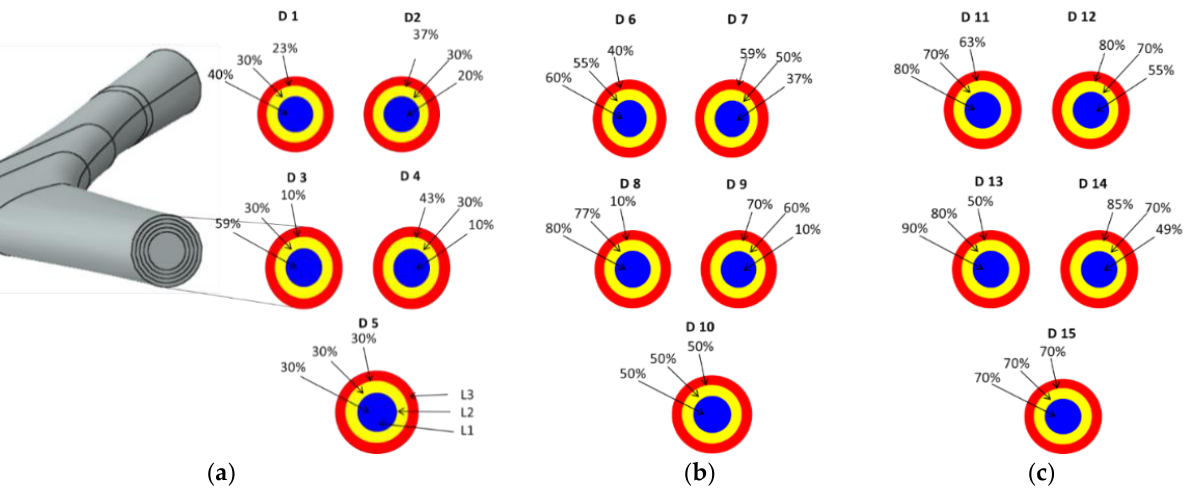
Figure 3. Porous functionally graded and homogeneous designs introduced to stem redial layers: ( a ) average porosity of 30%, ( b ) average porosity of 50%, ( c ) average porosity of 70%.